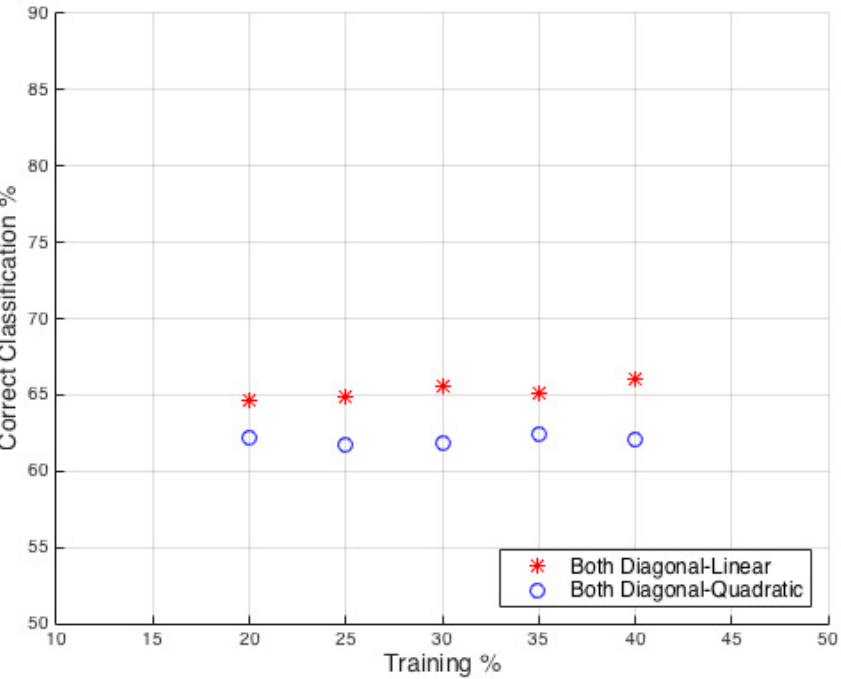
Figure 11. All individuals Data DA Classifier: Classification accuracy plotted against percentage of training set size used. training set size used.